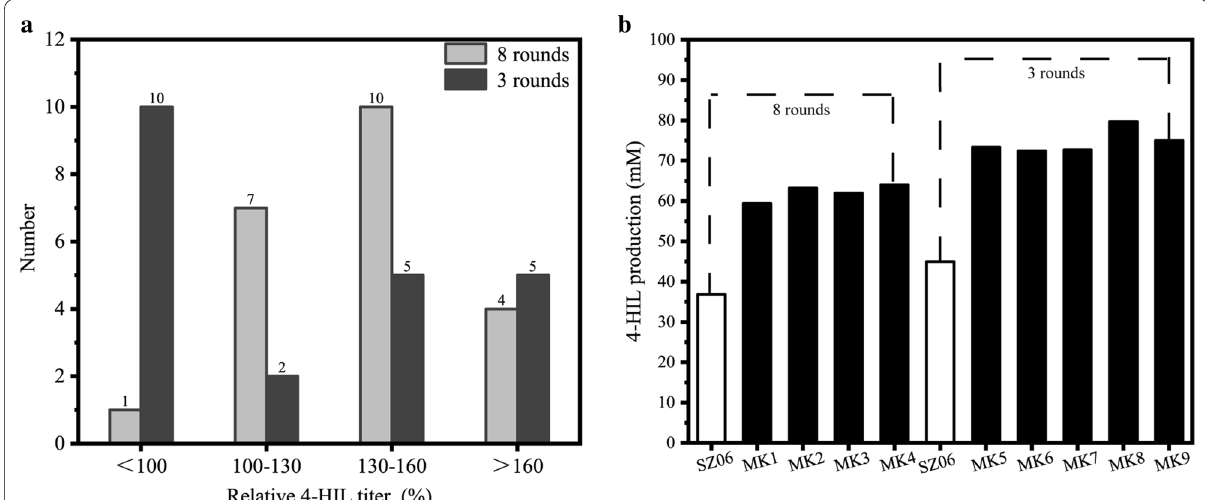
Fig. 3 The 4-HIL production of preliminary screening strains in 24 deep-well plates after fermented for 96 h. SZ06 was used as the control strain. a The distribution of relative 4-HIL production of mutant strains obtained by eight rounds or three rounds’ evolution. b mutant strains with a relative titer higher than 160%, MK1 MK4 from the eighth round and MK5 MK9 from the third round, − −